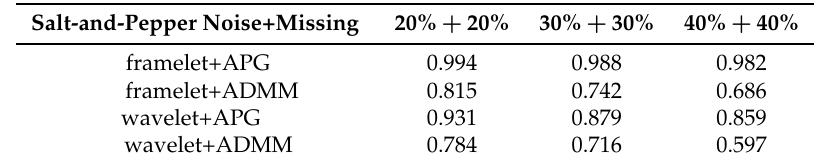
Table 3. Structural similarity index (SSIMs) for the lena image with different levels of salt-and-pepper noise and data missing.